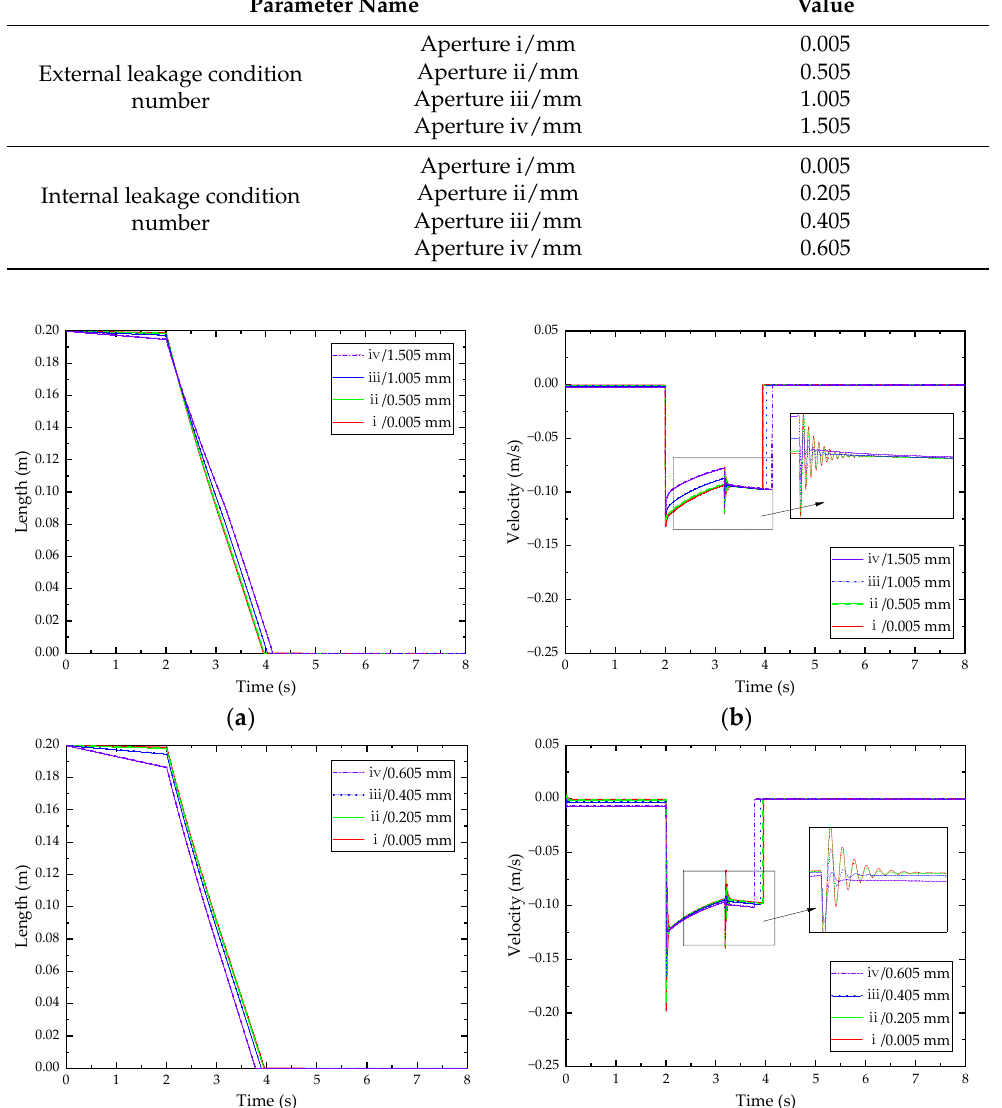
( b ) Figure 14. Effect of pipe joint leakage: ( a ) Piston displacement; ( b ) Piston Velocity. (9) Pipeline wear. Due to the general short installation spacing of hydraulic pipes in airplanes, contact may occur due to vibration and noise in the hydraulic system, and the pipelines rub against one other, causing wear. The space between parallel pipes must be more than 100 mm to prevent such contact, vibration, and wear between pipes. Nonetheless, harsh hy- draulic pipe and hydraulic hose wear in airplane landing gear cabins happens from time to time. Severe wear may cause pipe break due to the high pressure of the aircraft hydrau- lic system. (10) Oil intermingle in systems. In hydraulic A and B systems, hydraulic oil is usually physically segregated. Oil in- termingle in systems refers to the fact that oil is normally delivered by hydraulic system A during normal landing gear retraction/extension. However, owing to the operation of the landing gear switching valve, the oil will be delivered by hydraulic system B under specific situations. The A hydraulic system will still supply oil during the next operation of retracting and extending the landing gear, but hydraulic oil from the B hydraulic sys- tem in the pipeline will enter the A hydraulic system, resulting in a significant difference in oil volume between the A and B hydraulic systems. Oil intermingling in systems failure does not usually have a significant effect, but it might influence fuel tank pressurization and raise the cost of ground maintenance time. The deviation degree of fault effect may be calculated using Equations (5) and (6), as shown in Table 11, where